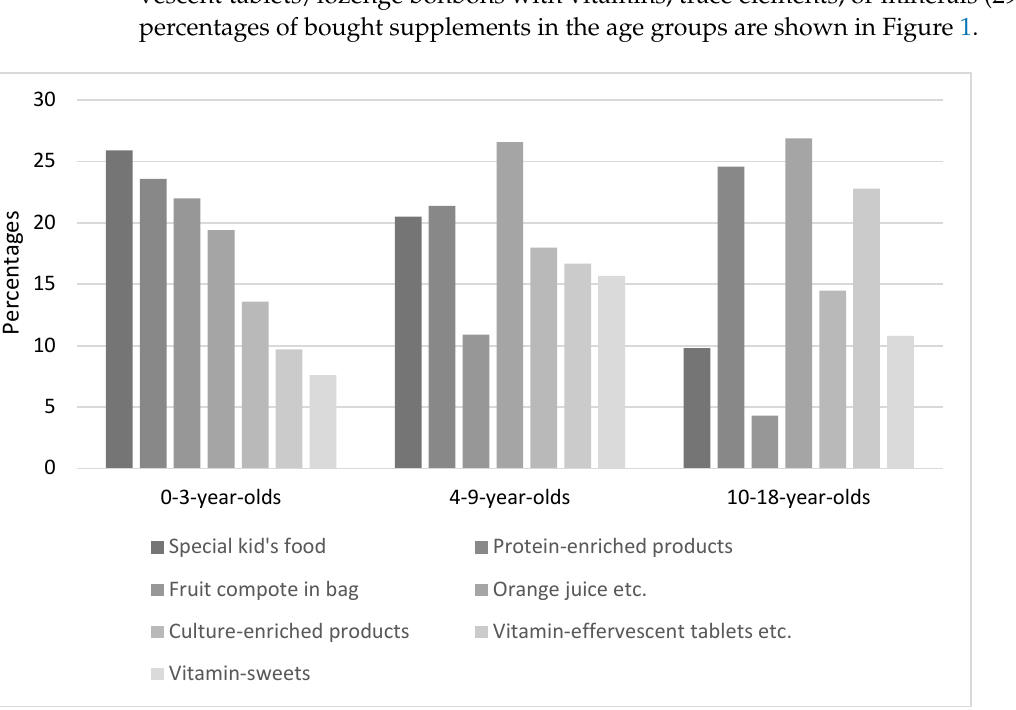
Table 2. Screen time and physical activity.